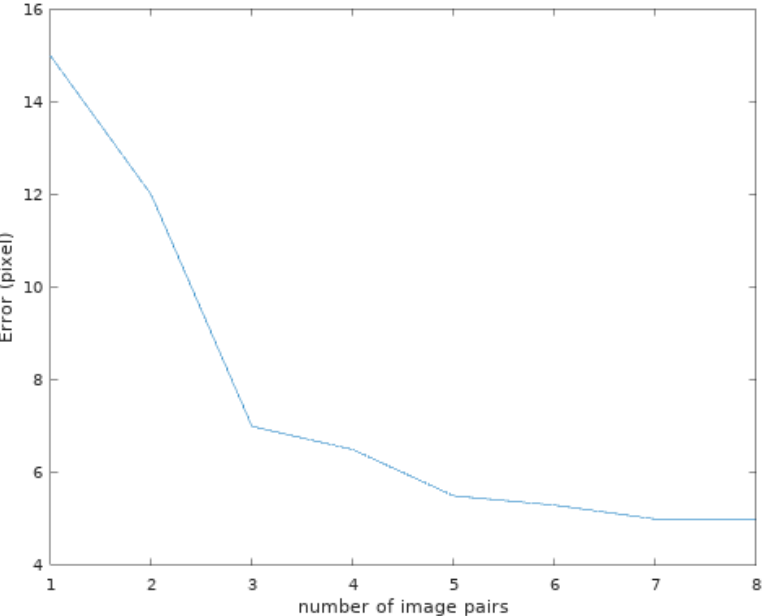
Figure 14. The mean reprojection error (in pixels) depending on the number of image pairs used for the calibration. As a reminder, the images have dimensions of 720 × 480 pixels.